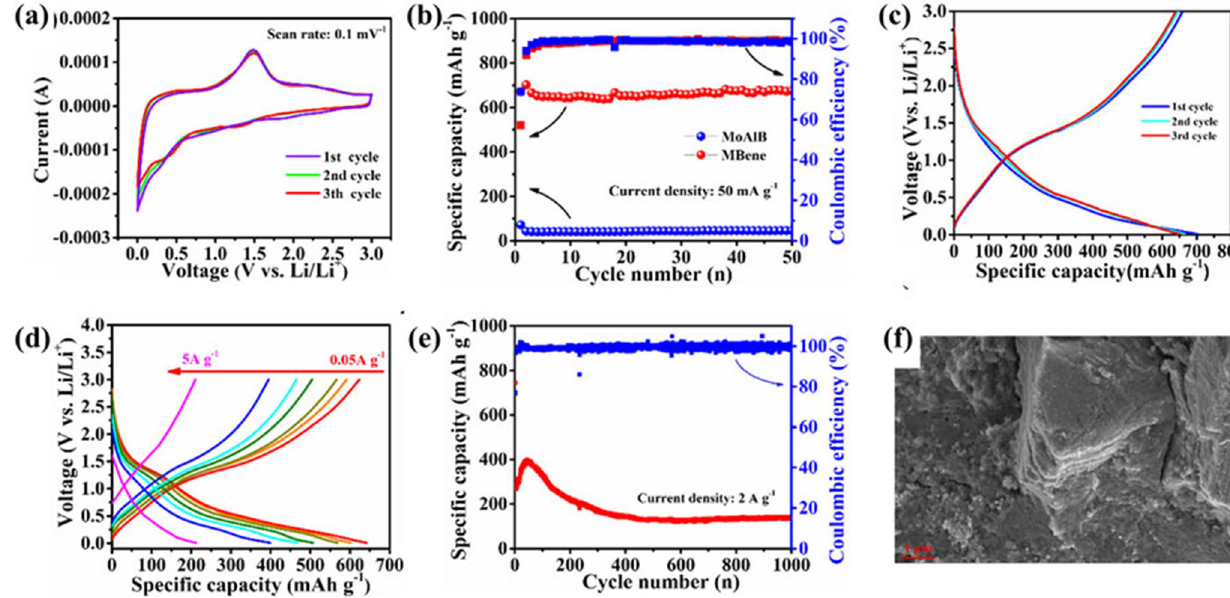
Fig. 22 Electrochemical performance of the 2D MoB MBene anodes in LIBs. a CV curves at a scan rate of 0.1 mVs −1 . b The cycle perfor- mance of MoAlB and 2D MoB MBene at 50 mA g −1 . c Charge–discharge curves at 50 mA g −1 . d The corresponding voltage curves of 2D MoB MBene and e long cycle performance at 2 mA g −1 . f SEM images of the surface morphology of 2D MoB MBene anode after electrochemical cycle. Reproduced with permission from Ref.